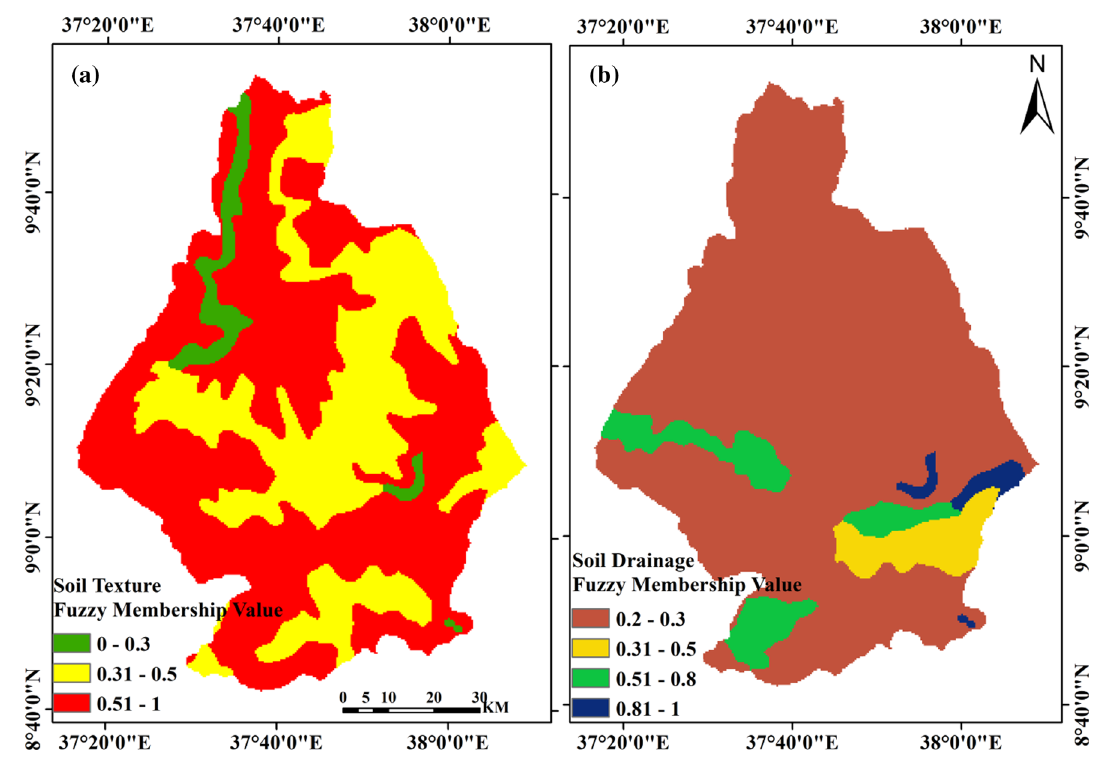
Fig. 10 Fuzzy membership values for a soil texture, b soil drainage Table 4 Criteria for the classification of soil texture Soil textural class